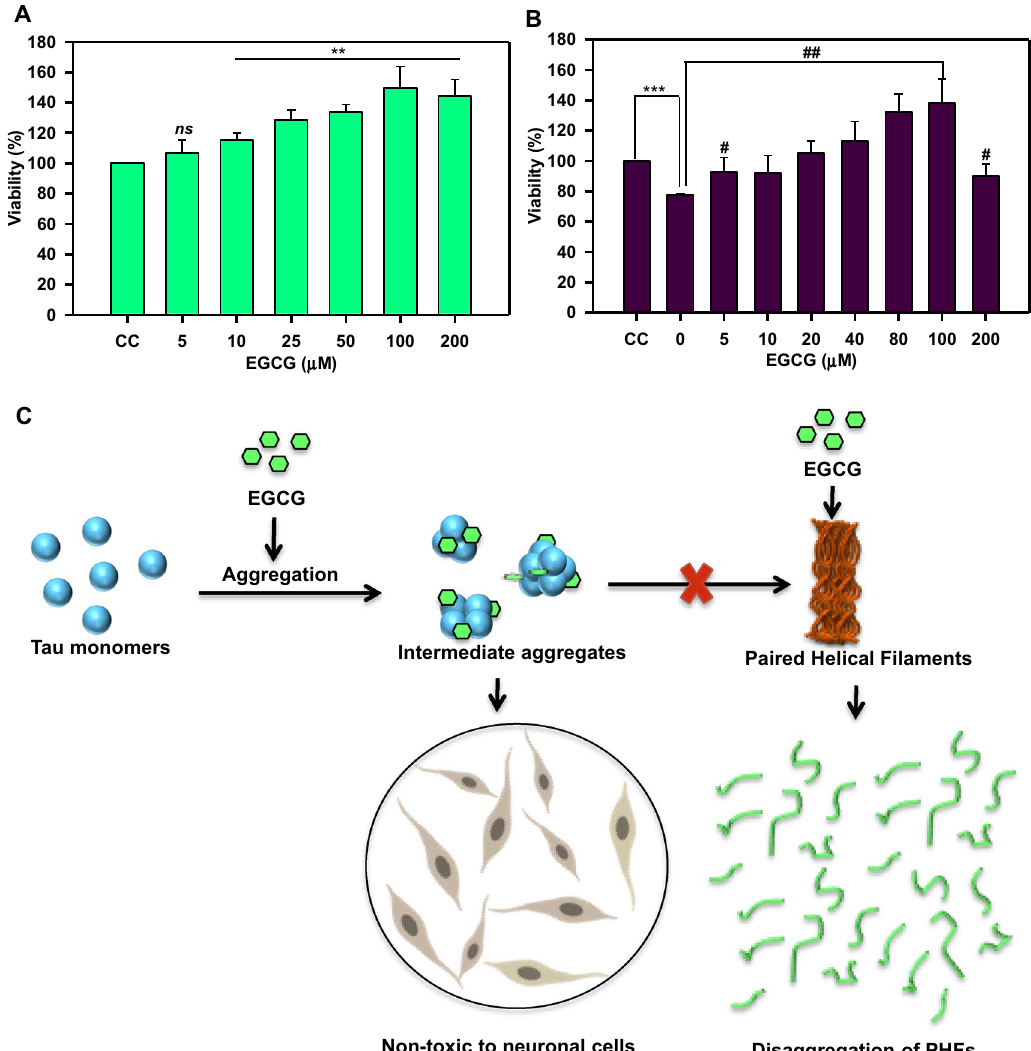
Figure 8. Effect of EGCG on cell viability. Toxicity was induced with 5 μM Tau aggregates and rescue in presence of EGCG (0–200 μM) in neuro2a cells. ( A ) Cell viability assay shows EGCG was non-toxic to neuronal cells at varying concentrations (0–200 μM) p < 0.001 and enhance the cell survival. ( B ) Tau aggregates induce toxicity in neuro2a cells at 0 μM EGCG p < 0.05(denoted as *) EGCG significantly rescues toxicity of Tau aggregate mediated toxicity till and enhances viability p < 0.05 (denoted as #). ( C ) EGCG inhibits Tau aggregation by forming intermediate Tau aggregates and disintegrating them. The intermediate aggregates formed are non-toxic to neuronal cells. On the other hand, when matured Tau fibrils are treated with EGCG, they are disaggregated and